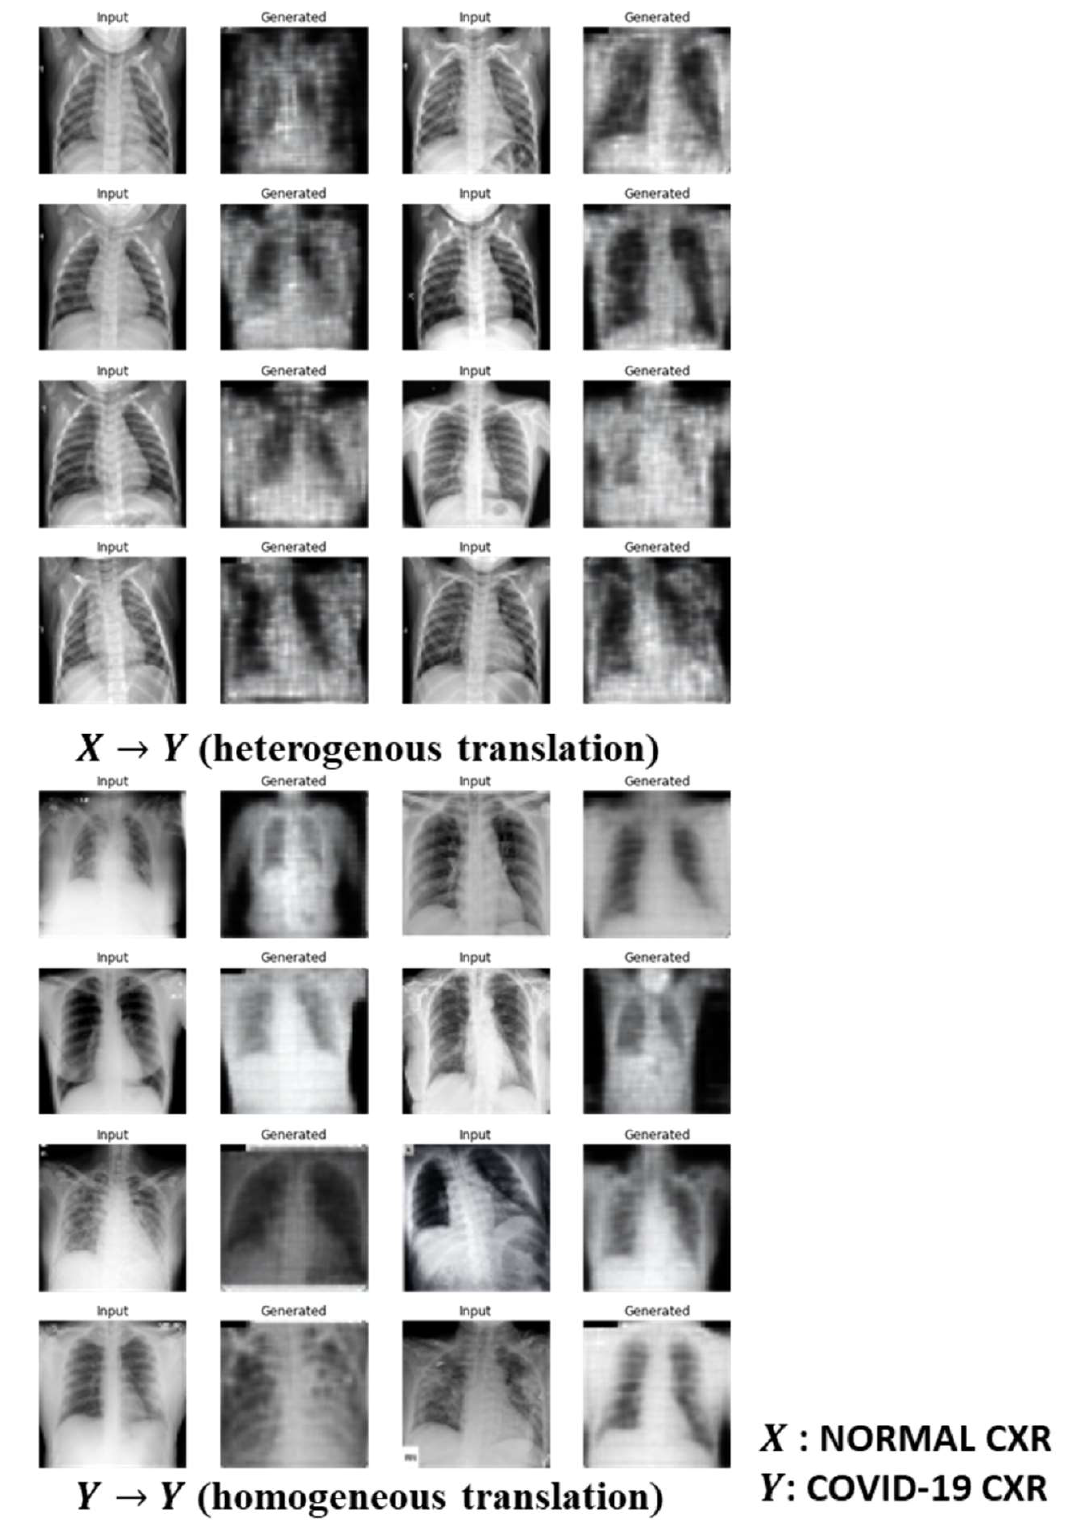
Figure 3. Image translation by Cycle GAN.